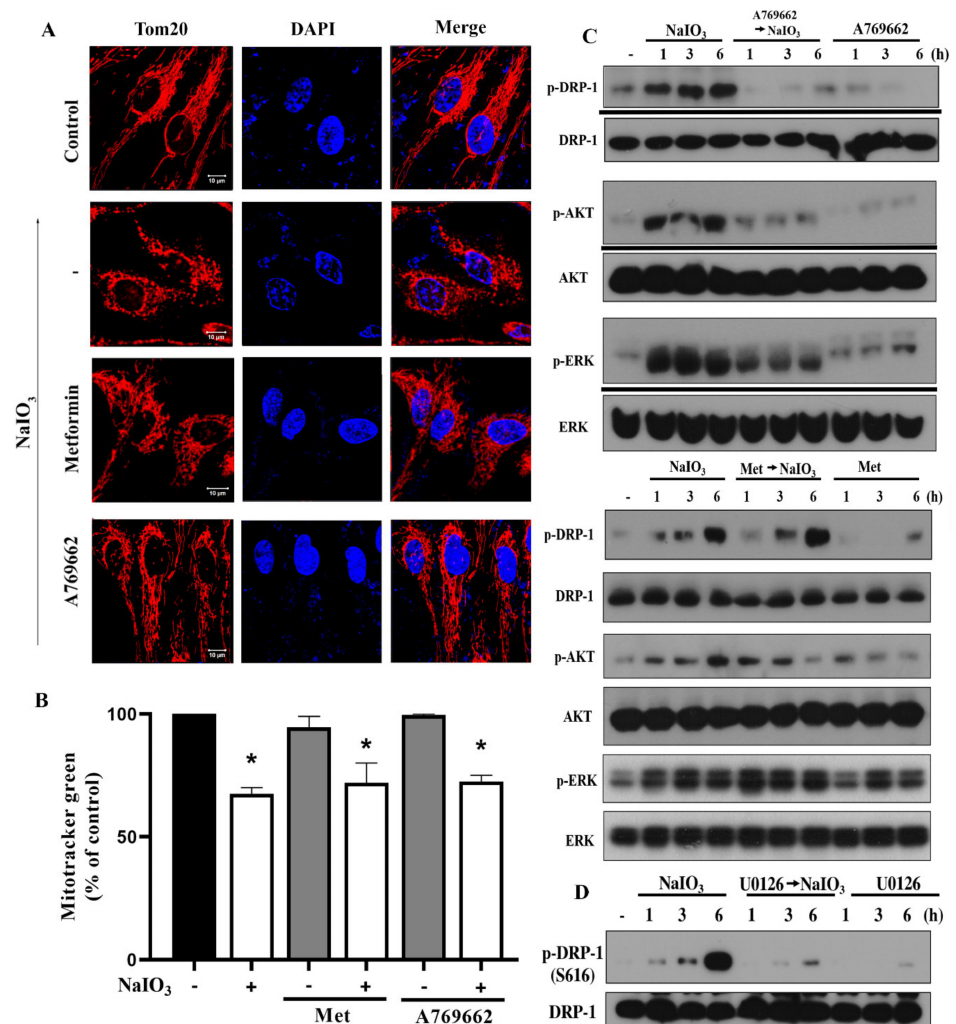
Figure 5. A769662 but not metformin reverses the NaIO 3 -induced mitochondrial fission and Drp-1 phosphorylation. After treatment with metformin (6 mM), A769662 (30 µ M) and / or NaIO 3 (30 mM) for 6 h, Tom20 and DAPI staining were conducted. Scale bars indicated 10 µ m ( A ). Mitochondrial mass was determined by Mitotracker green staining followed by flow cytometry ( B ). Data were mean ± SEM from three independent experiments. * p < 0.05, indicating the significant e ff ect of NaIO ( C , D ) After treatment with indicated agents, cell lysates were prepared for immunoblotting. Data were representative of three independent